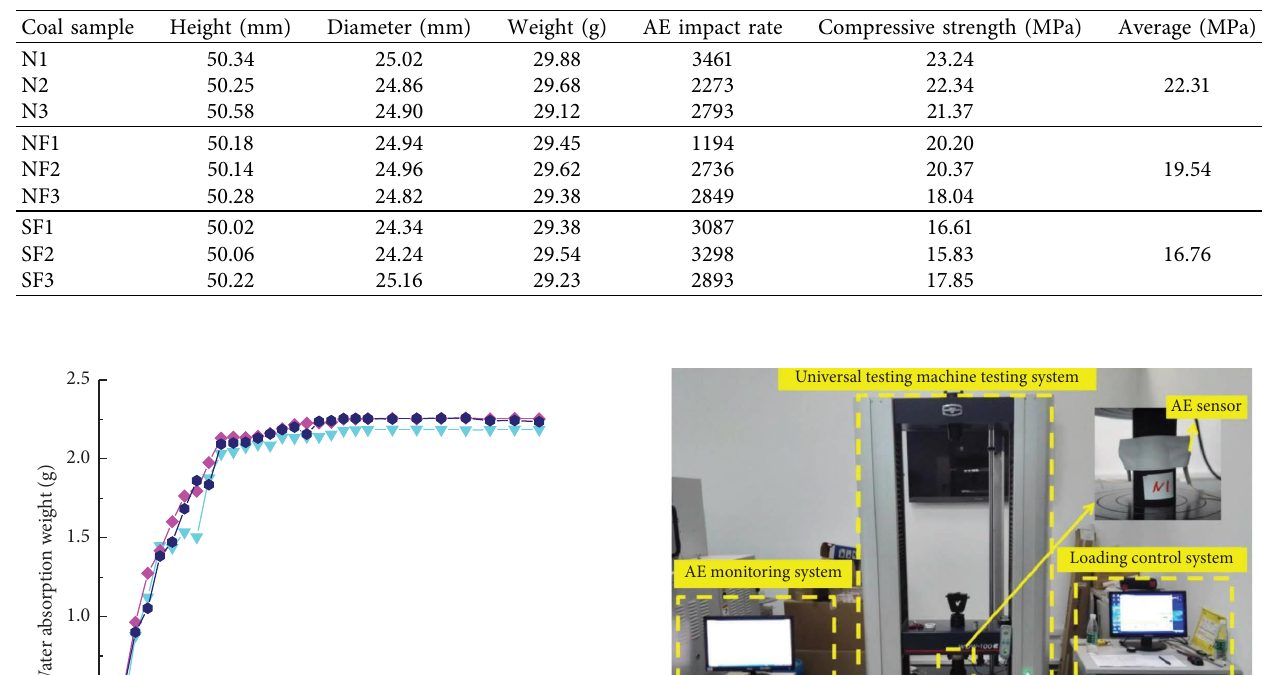
Table 1: Physical and mechanical parameters of coal samples.